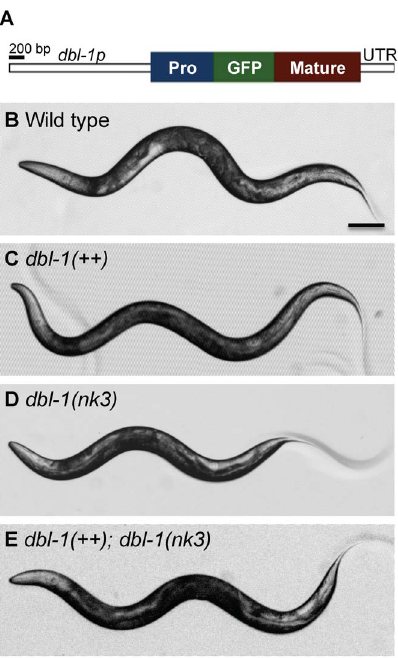
Figure 1. GFP-tagged DBL-1 is bioactive. (A) Schematic diagram of GFP-tagged DBL-1 expressed from the dbl-1 promoter ( dbl-1p ). The GFP-tag (green) is inserted downstream of the prodomain (blue) and upstream of the DBL-1 mature domain (red). The construct also contains the dbl-1 specific 3 9 untranslated region (UTR). (B–E) Body lengths of wild-type (B), dbl-1( ++ ) (C), dbl-1(nk3) (D), and dbl-1(nk3) mutant animals expressing the GFP-tagged DBL-1 transgene (E). Scale bar = 100 m